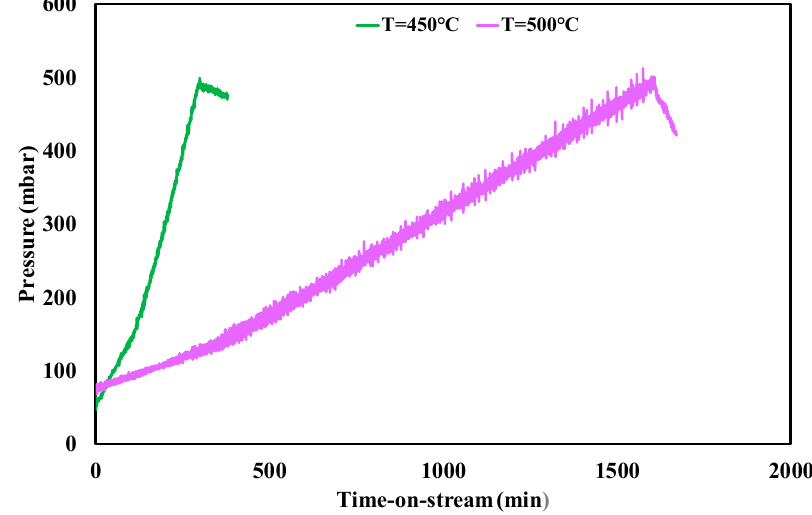
Figure 5. Pressure drops profile through the catalytic bed during stability tests and gasification measurements at f.r. = 3 and different temperatures; WHSV = 4.1 h − 1 .